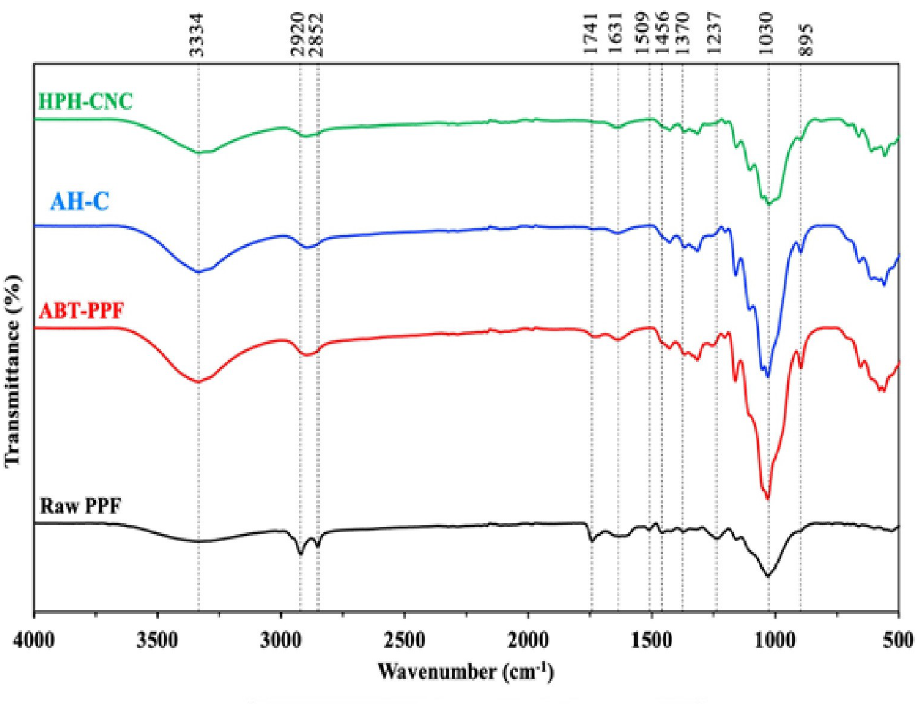
Fig 6. FTIR spectra of Raw PPF, ABT-PPF, AH-C and HPH-CNC.